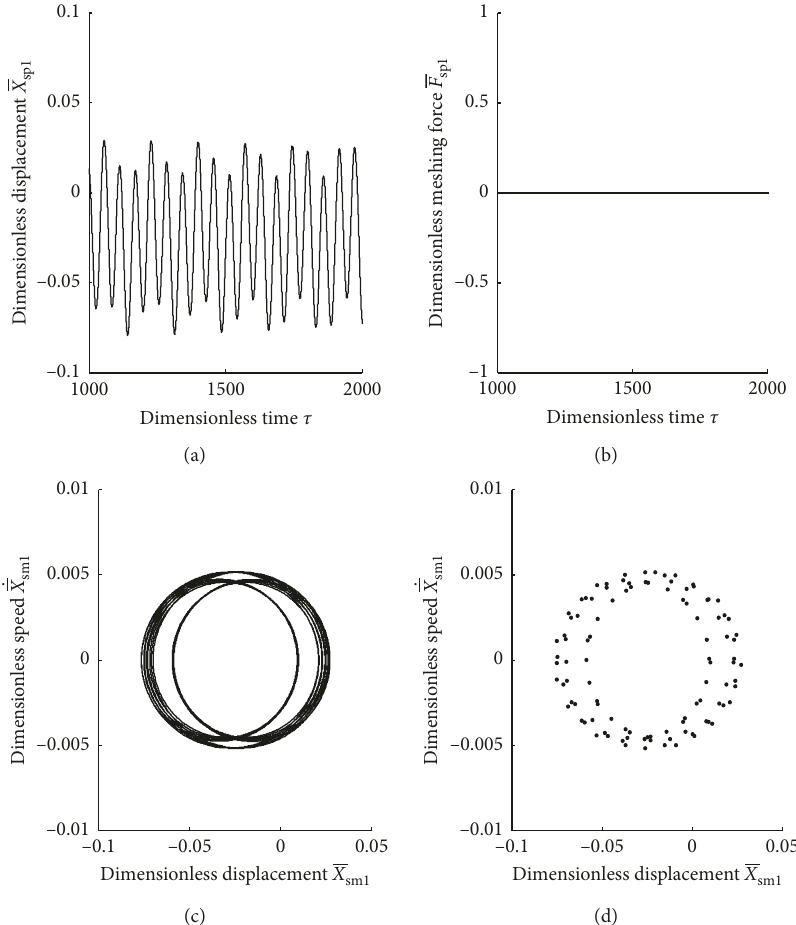
Figure 7: Process diagrams of response, phase diagram, and Poincar´e section under b � 70 μ m for differential stage. (a) Time process diagram of displacement response. (b) Time process diagram of meshing force response. (c) Phase diagram. (d) Poincar´e